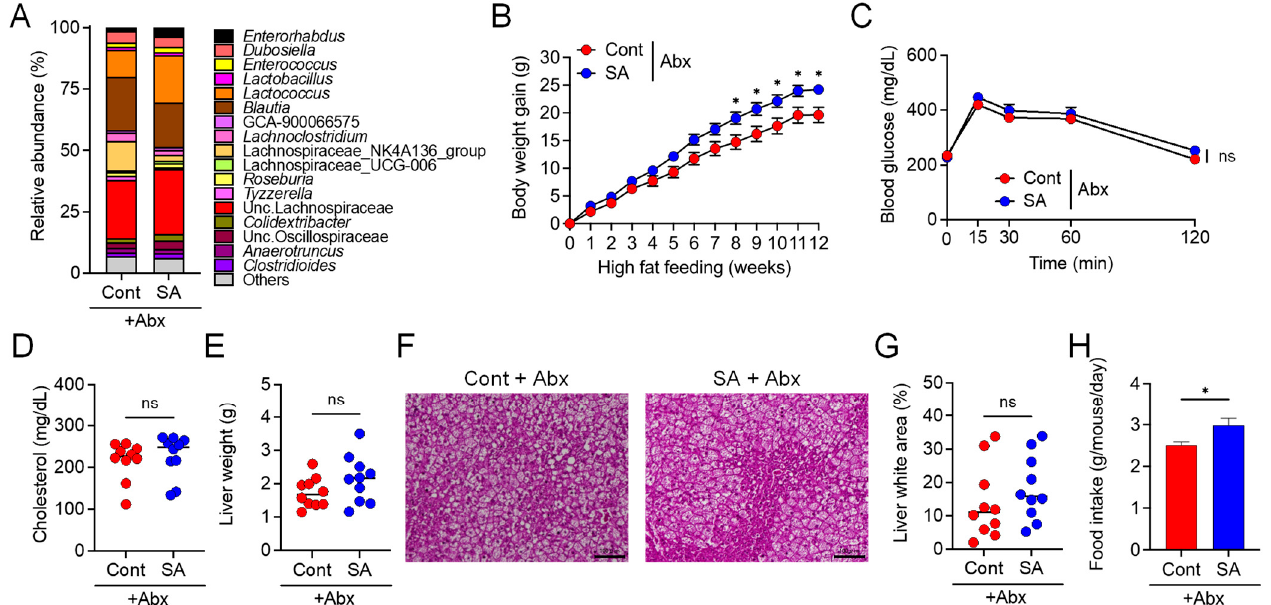
Figure 3. Gut microbiota was involved in the sodium alginate (SA)-mediated suppression of high fat diet (HFD)-induced MetS. Mice were fed a HFD supplemented with or without 5% SA for 12 weeks and subjected to antibiotic (Abx) treatment ( n = 10 mice per group). ( A ) Relative abundance of ASVs in feces of mice maintained on a HFD supplemented with or without 5% SA for 4 weeks. The different colors correspond to different bacterial genera, as indicated. ( B ) Body weight gain. ( C ) Blood glucose levels, as measured via an OGTT. ( D ) Plasma cholesterol levels. ( E ) Liver weight. ( F ) Representative images of lipid droplet-containing areas (white areas) and ( G ) percentage of lipid droplet-containing areas in H&E stained liver sections. Scale bar, 100 µ m. ( H ) Daily food intake of the mice. Each dot represents an individual mouse, and the horizontal bars indicate mean values. Statistical significance was assessed by an unpaired Student’s t -test in ( E , G ), Mann–Whitney U-test in ( D , H ), and two-way analysis of variance (ANOVA) with Sidak’s multiple comparisons test in ( B , C ). * p < 0.05; n.s., not significant. Cont: HFD diet; SA: HFD diet with 5% sodium alginate; Abx: erythromycin